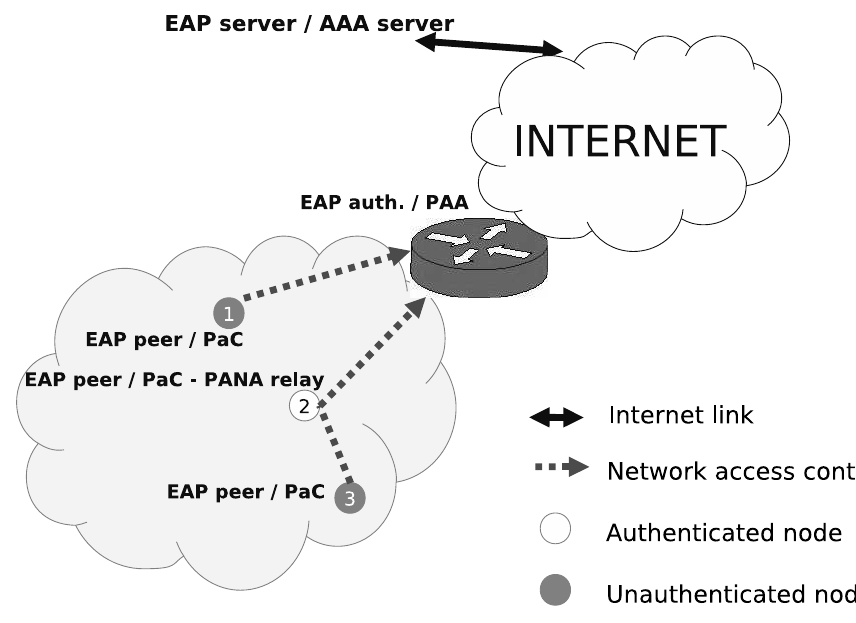
Figure 4. PANA framework for network connectivity and access